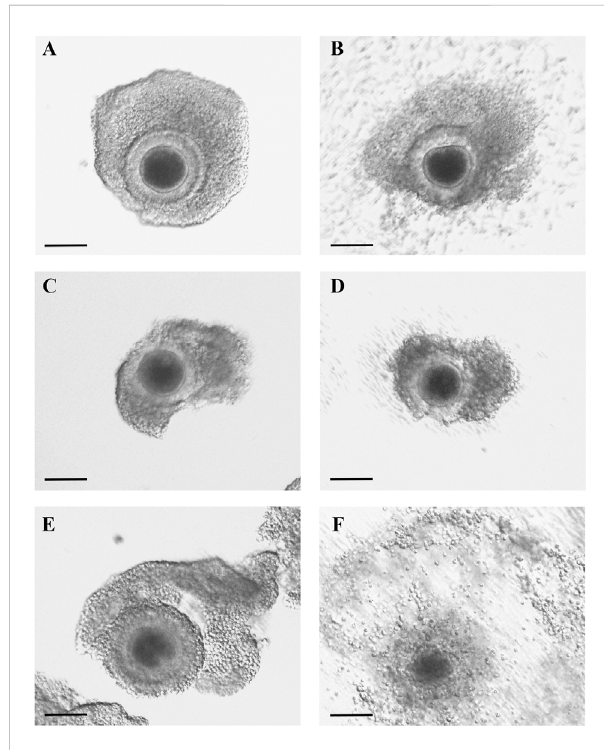
FIGURE 3 MCP1 restored C-OE inhibited by the EGFR inhibitor. Representative images of feline COCs from C-OE culture were taken prior to (A,C,E) and at the end of culture 24 h; (B,D,F) . COCs were incubated (24 h) with GNT (A – B) , GNT + LAPATINIB (C – D) , GNT + LAPATINIB + MCP1 (E – F) . Scale bars 100 μ